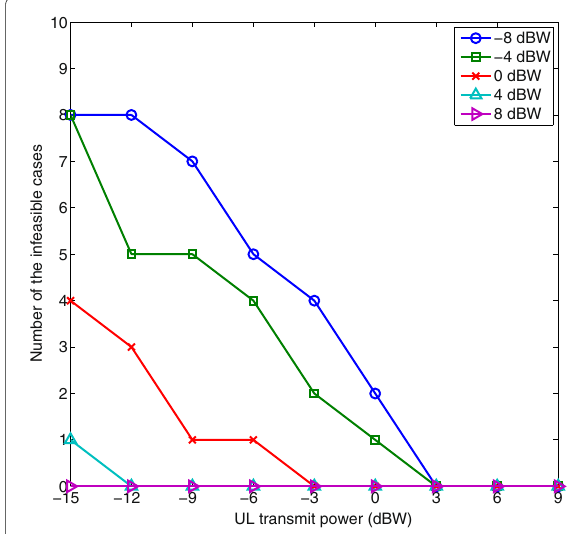
Fig. 5 The infeasible case occurs among 1000 channel realizations for different transmit power